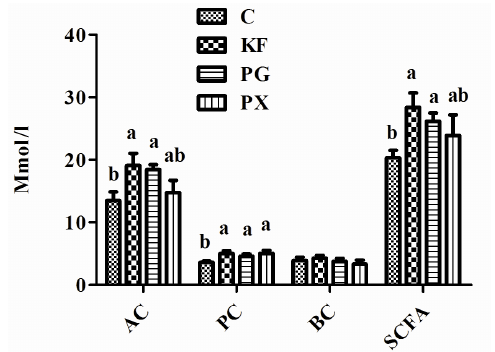
Figure 4. Concentration of SCFAs in cecal contents of rats given diets containing different dietary fibers for three weeks. Diets were control (C) or supplemented with 2% fiber of konjac flour (KF), pregelatinized waxy maize starch plus guar gum (PG) or pregelatinized waxy maize starch plus xanthan gum (PX); Values are mean ± SEM of n = 6–8 per group. Bars with different letters indicate a significant difference ( p < 0.05). SCFAs, short-chain fatty acids; AC, acetate acid; PC, propionate acid; BC, butyrate acid.